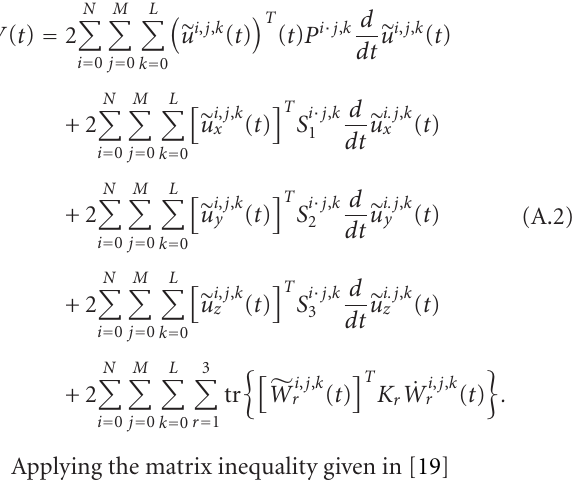
Figure 9: Comparison between 3D PDE trajectories and 3D DNN approximation for coordinate z at time 46 days.